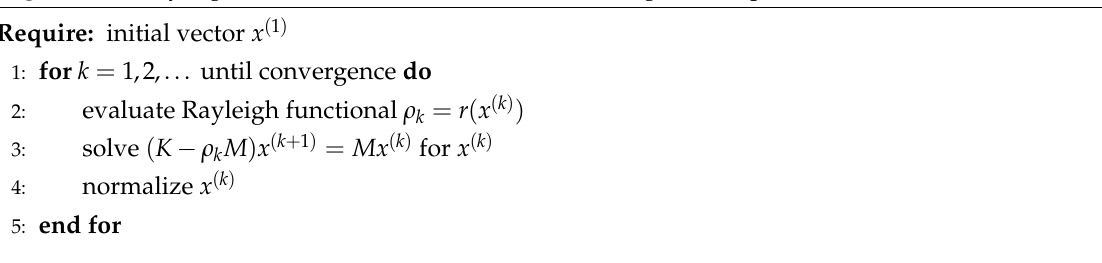
Algorithm 1 Rayleigh functional iteration for fluid–solid eigenvalue